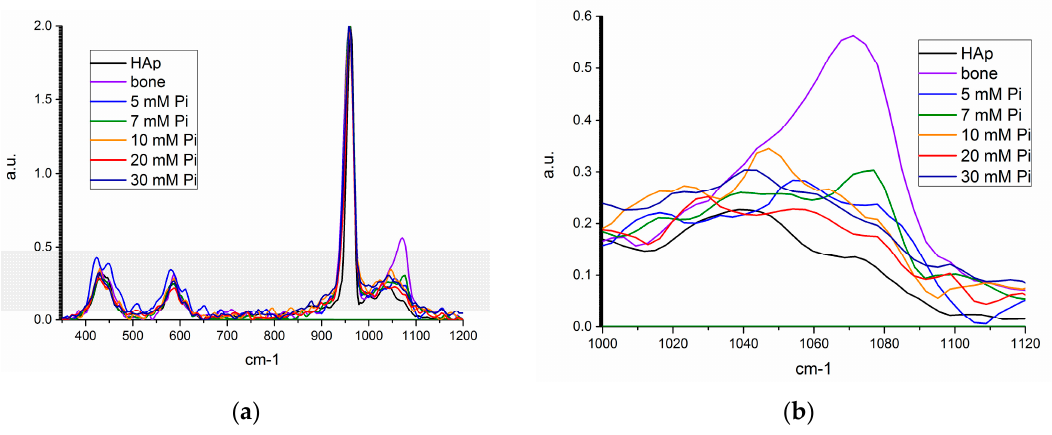
Figure 8. Raman spectra for synthetic hydroxyapatite (HAP, black), bone mineral (violet), unseeded precipitate from 5 (blue), 10 mM (orange), 20 mM (red), and 30 mM (navy), and 7 mM seeded precipitate (green) from ( a ) 350–1200 cm − 1 , and ( b ) 1000–1120 cm − 1 .